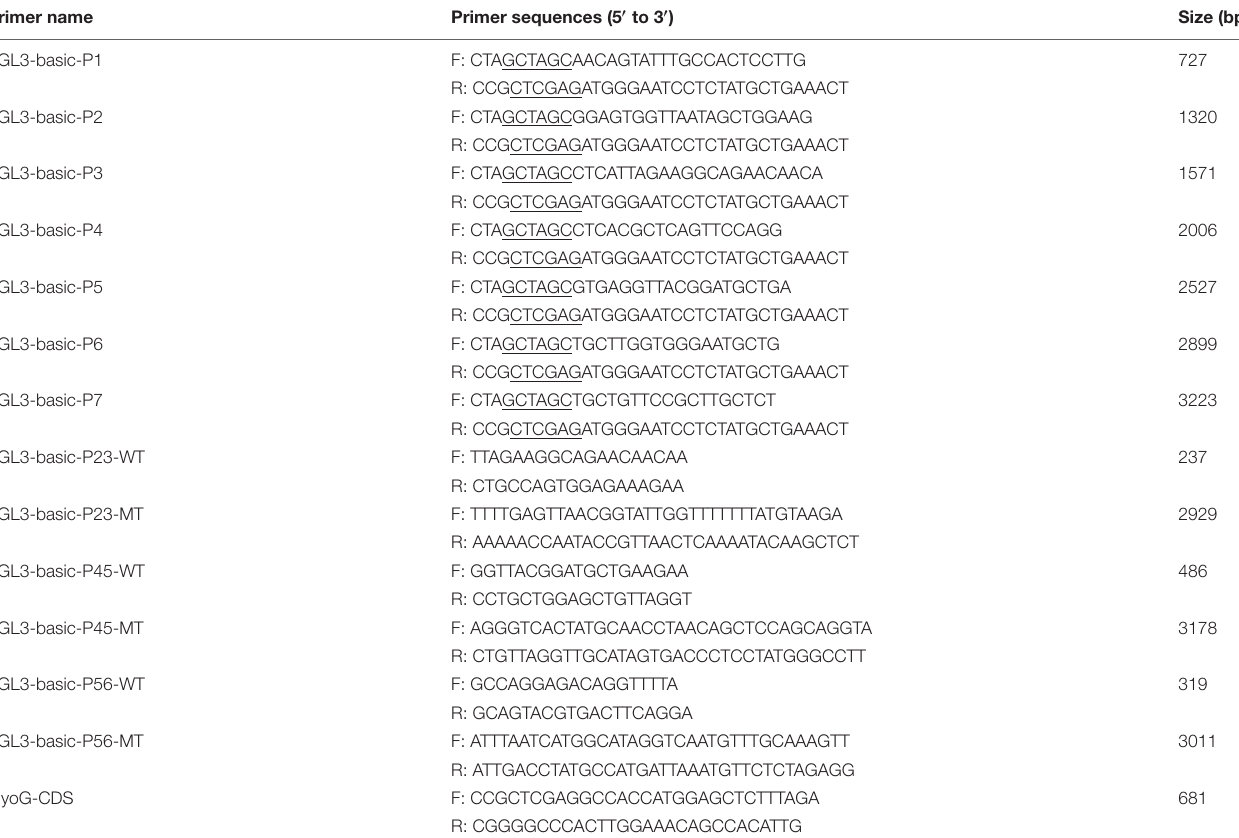
TABLE 1 | Primers used for vector construction. Primer name